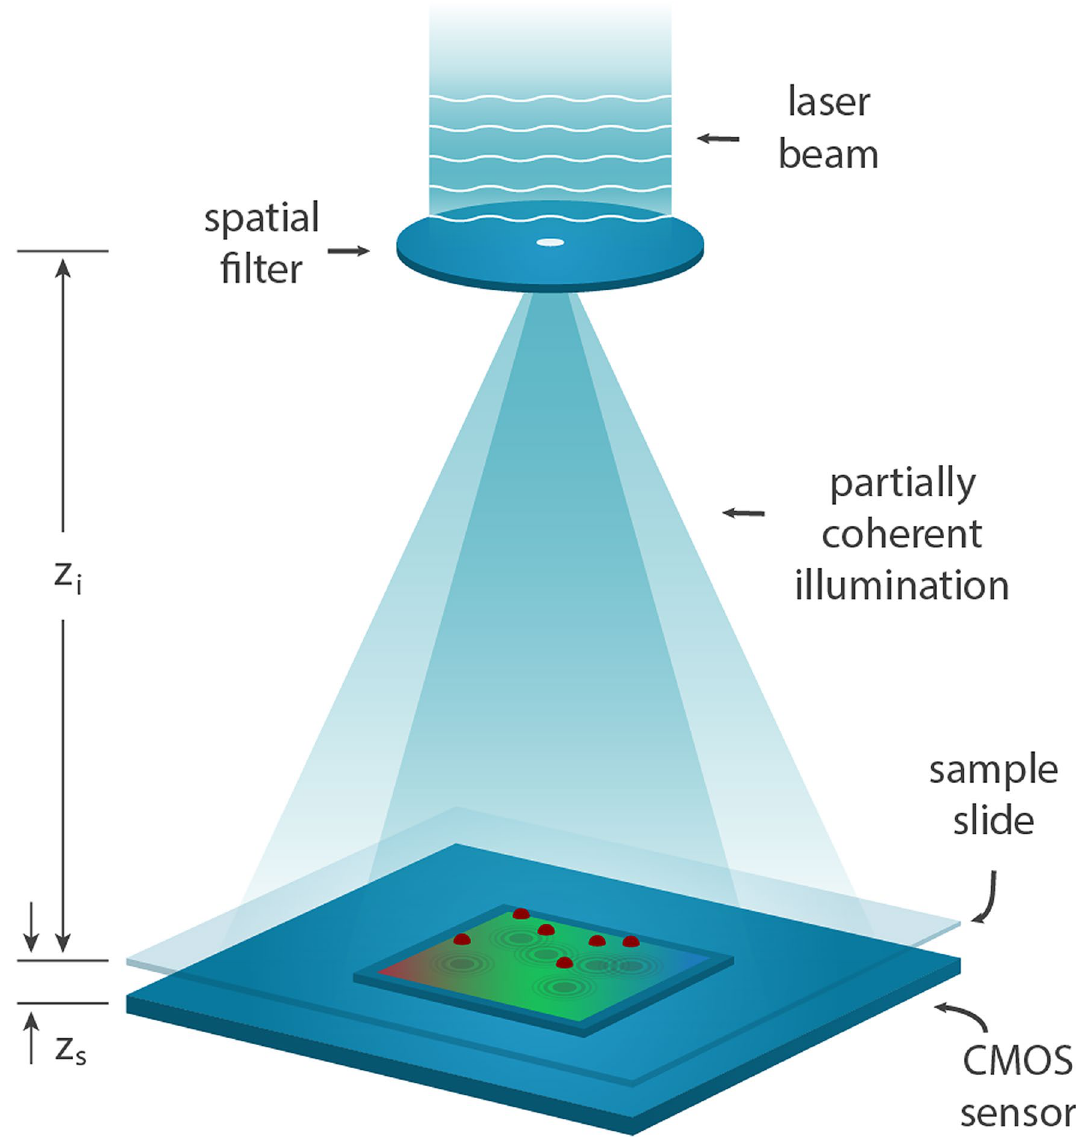
Figure 7. Sketch of the experimental setup for z i ≃ 10cm and z s < 2mm